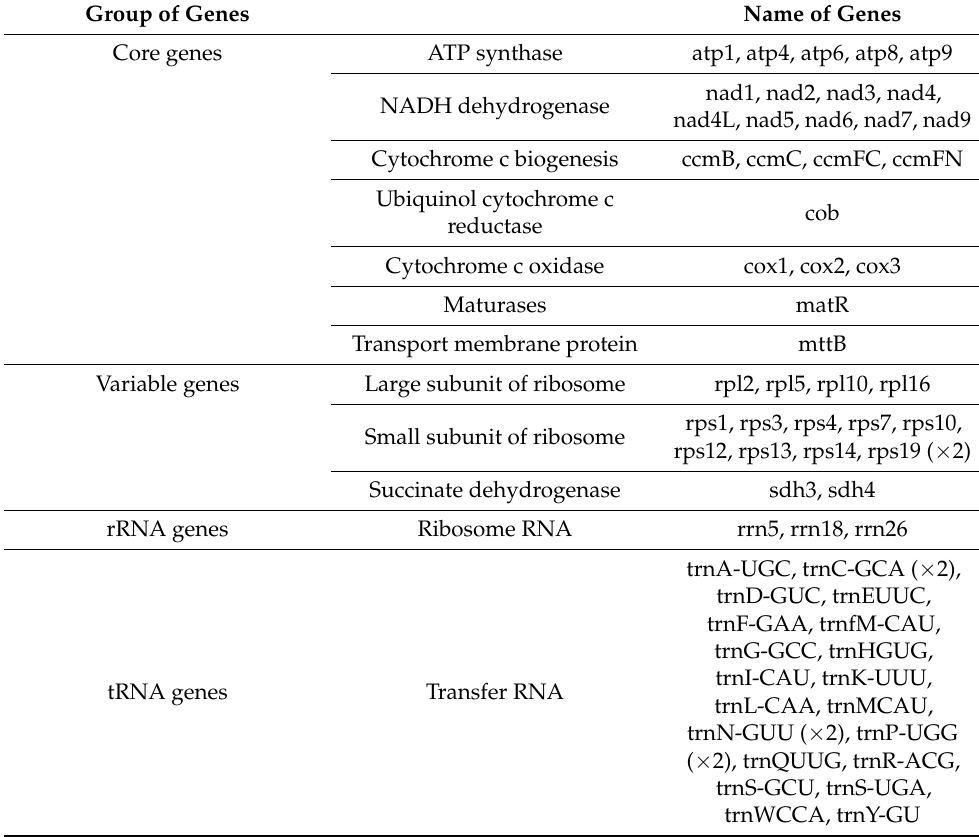
Table 1. Gene composition in the mitogenome of bitter gourd. Group of